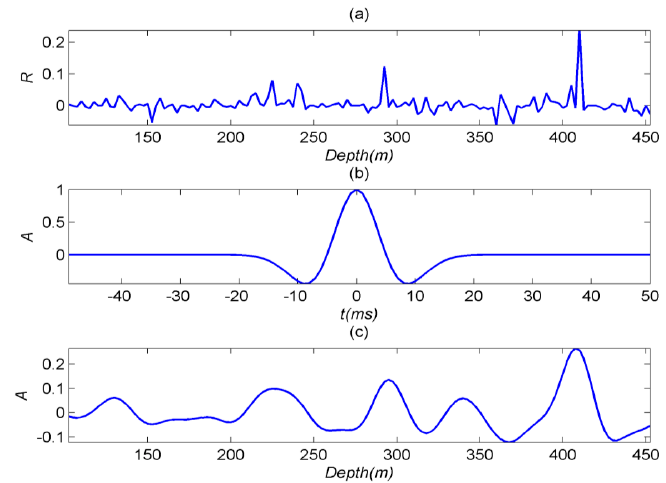
Figure 4. ( a ) Reflection coefficient; ( b ) Ricker wavelet; and ( c ) synthetic seismic record.